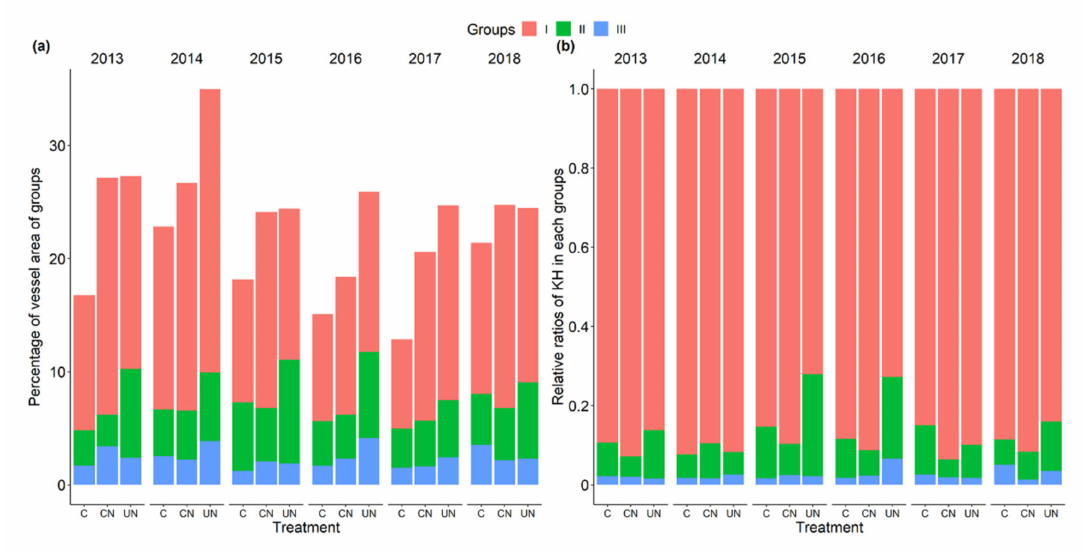
Figure 4. Percentage of vessel area ( a ) and KH ( b ) of group I, II and III of Q. variabilis under control (C), canopy N addition (CN) and understory N addition (UN) treatments conditions during 2013–2018. Error bars indicate standard